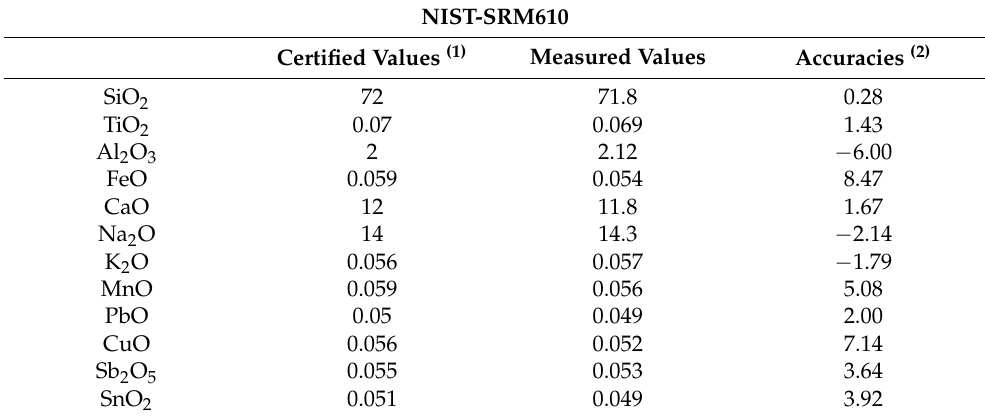
Table 2. Analyses of NIST SRM610 standard glass. Comparison between certified and measured values. NIST-SRM610 Certified Values